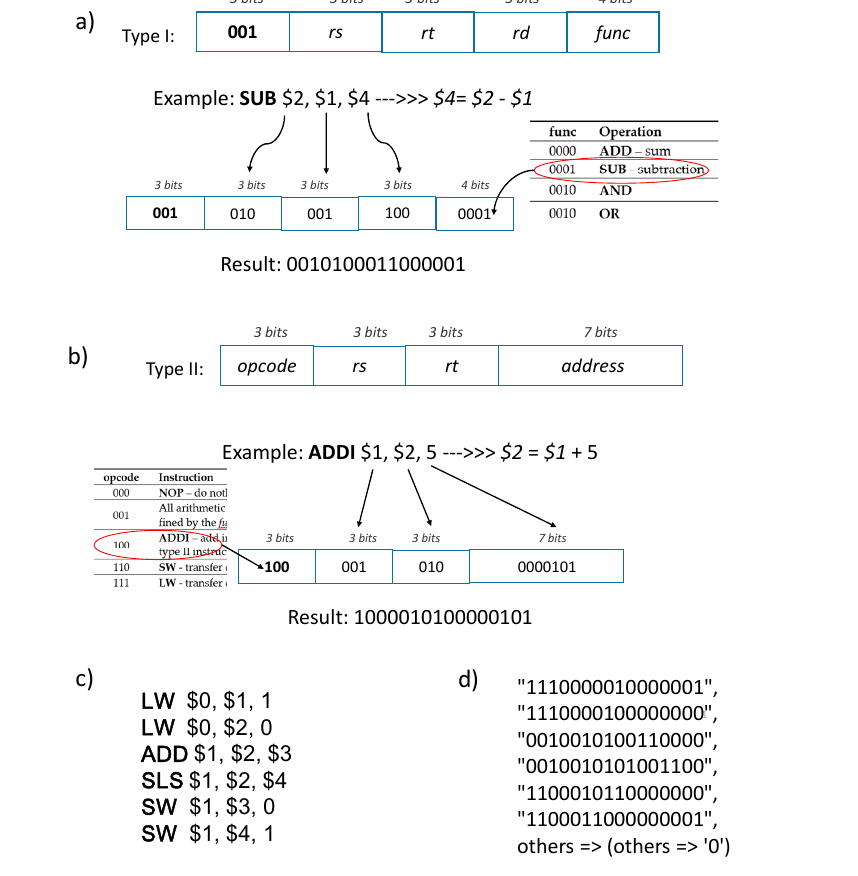
Figure 3. Examples of instruction encoding: ( a ) type I; ( b ) type II; ( c ) a short assembly program given to students for translation to the machine code; ( d ) the result of conversion to machine code in the format of VHDL code to be used for initialization of the instruction